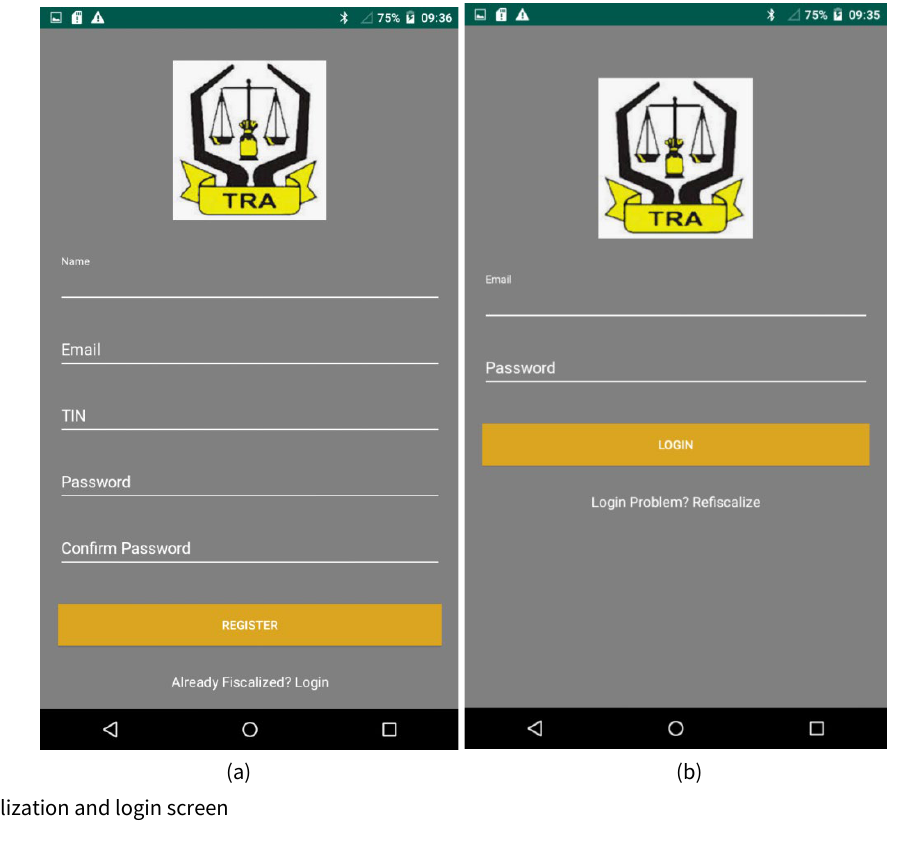
Figure 5. Fiscalization and login